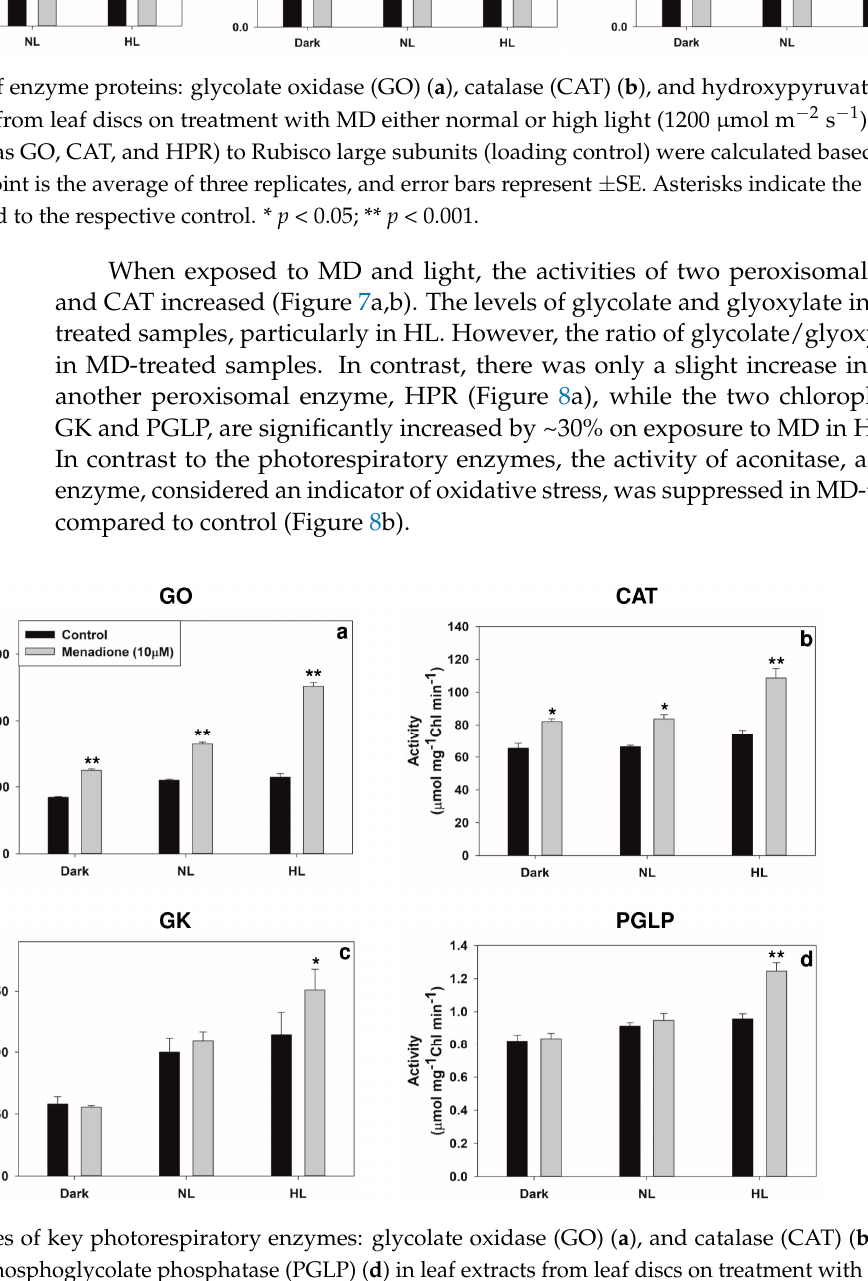
Figure 6. The levels of enzyme proteins: glycolate oxidase (GO) ( a ), catalase (CAT) ( b ), and hydroxypyruvate reductase (HPR) ( c ), in extracts from leaf discs on treatment with MD either normal or high light (1200 µmol m − 2 s − 1 ). The ratios of each protein (such as GO, CAT, and HPR) to Rubisco large subunits (loading control) were calculated based on ImageJ software. Each data point is the average of three replicates, and error bars represent ±SE. Asterisks indicate the significance of MD effect compared to the respective control. * p < 0.05; ** p < 0.001.